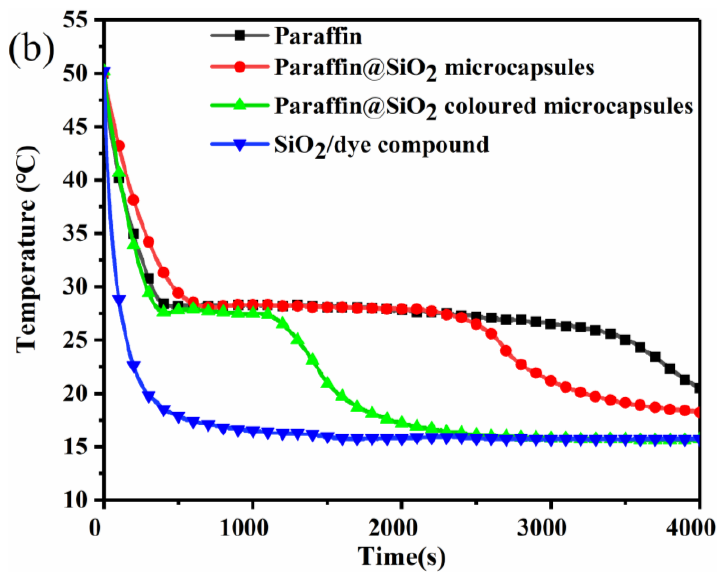
Figure 10. The temperature/time curves ( a ) under the simulated solar irradiance of 500 W·m −2 and ( b ) natural cooling at ambient temperature of 15 ℃ of pristine paraffin, paraffin@SiO 2 microcap- ( b ) natural cooling at ambient temperature of 15 ◦ C of pristine paraffin, paraffin@SiO 2 microcapsules, sules, the paraffin@SiO 2 colored microcapsules, and SiO 2 nanoparticles. the paraffin@SiO 2 colored microcapsules, and SiO 2 nanoparticles.